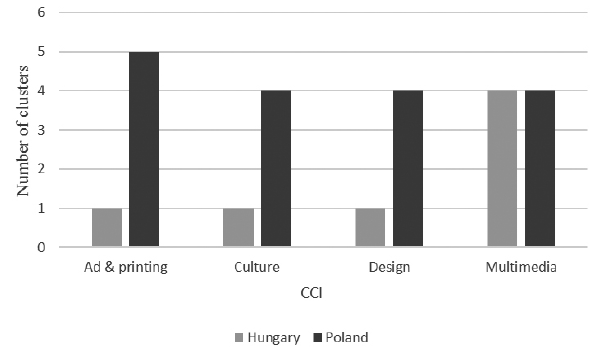
Fig. 1. Types of clusters participating in the study (source: created by authors, based on own research of cultural and creative clusters in the